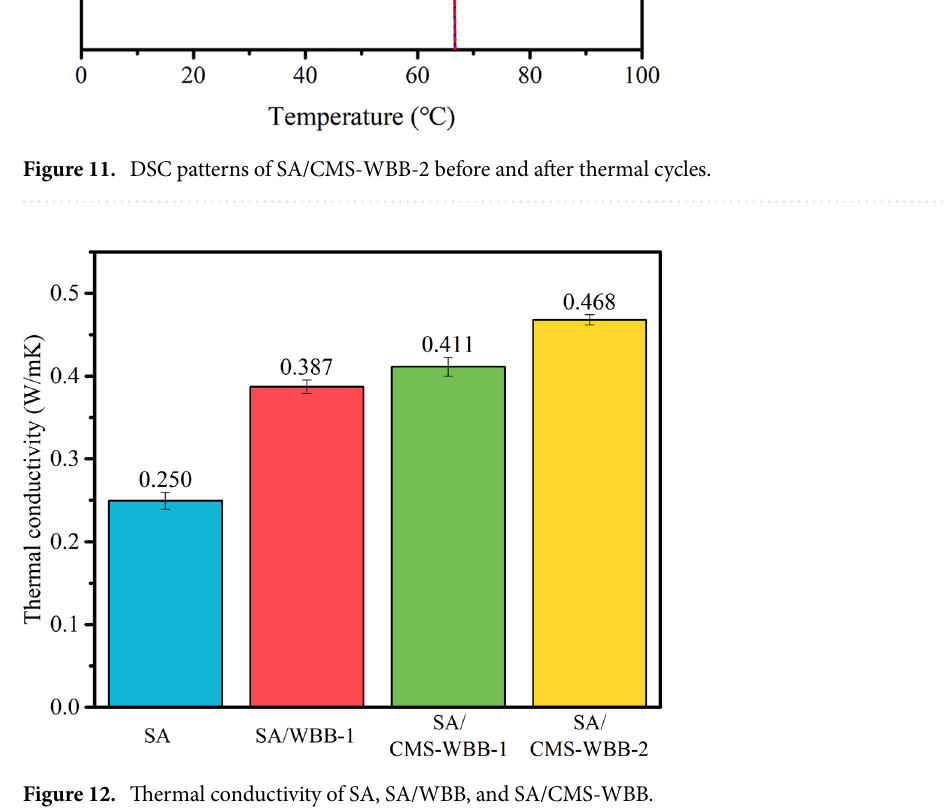
Figure 12. Thermal conductivity of SA, SA/WBB, and